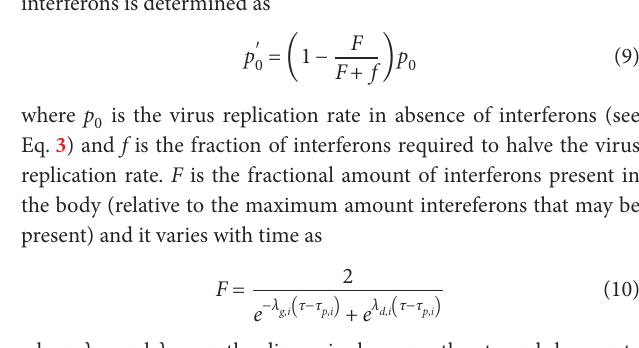
and the infectious phase, respectively. c